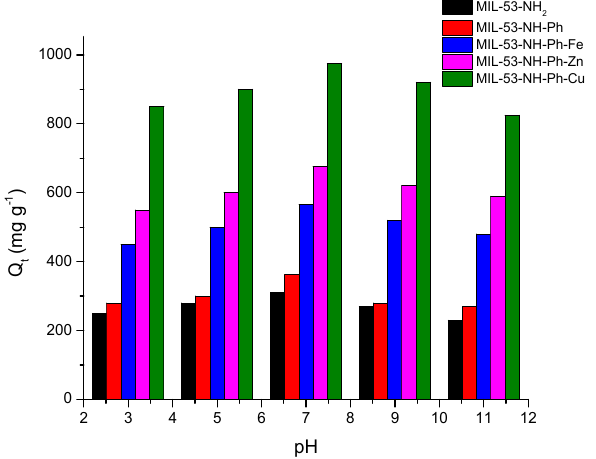
Figure 7. Effect of pH on the uptake of carbofuran onto MIl − 53 − NH 2 , MIL − 53 − NH − ph, MIL − 53 − NH − ph − Fe, MIL − 53 − NH − ph − Zn, and MIL − 53 − NH − ph − Cu (Dosage: 30 mg L − 1 , speed = 400 rpm, time: 120 min, pesticide concentration: 30 mg L − 1 , and T = 303 k).